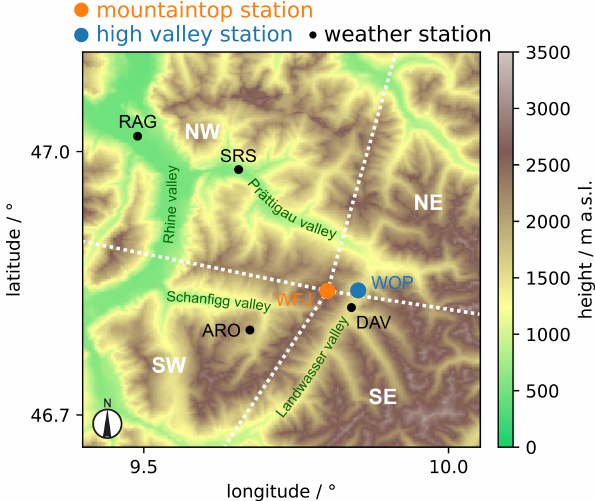
Figure 1. Locations of the measurement sites. The main aerosol measurements were located at Wolfgangpass (blue; WOP; 1631ma . s . l . ) and Weissfluhjoch (orange; WFJ; 2693ma . s . l . ). The horizontal distance between WOP and WFJ measures 3.65km. Meteorological data were retrieved from measurement stations in Arosa (ARO; 1880ma . s . l . ), Bad Ragaz (RAG; 498ma . s . l . ), Davos Dorf (DAV; 1598ma . s . l . ), Schiers (SRS; 628ma . s . l . ), and at Weiss- fluhjoch (WFJ; 2693ma . s . l . ). The white dashed lines indicate the edges of the four mesoscale wind direction sectors (NW, NE, SW, and SE) used for the analysis based on the topography used in Sect. 3.3–3.5. The topography was extracted from the digital height model DHM200 from the Federal Office of Topography,